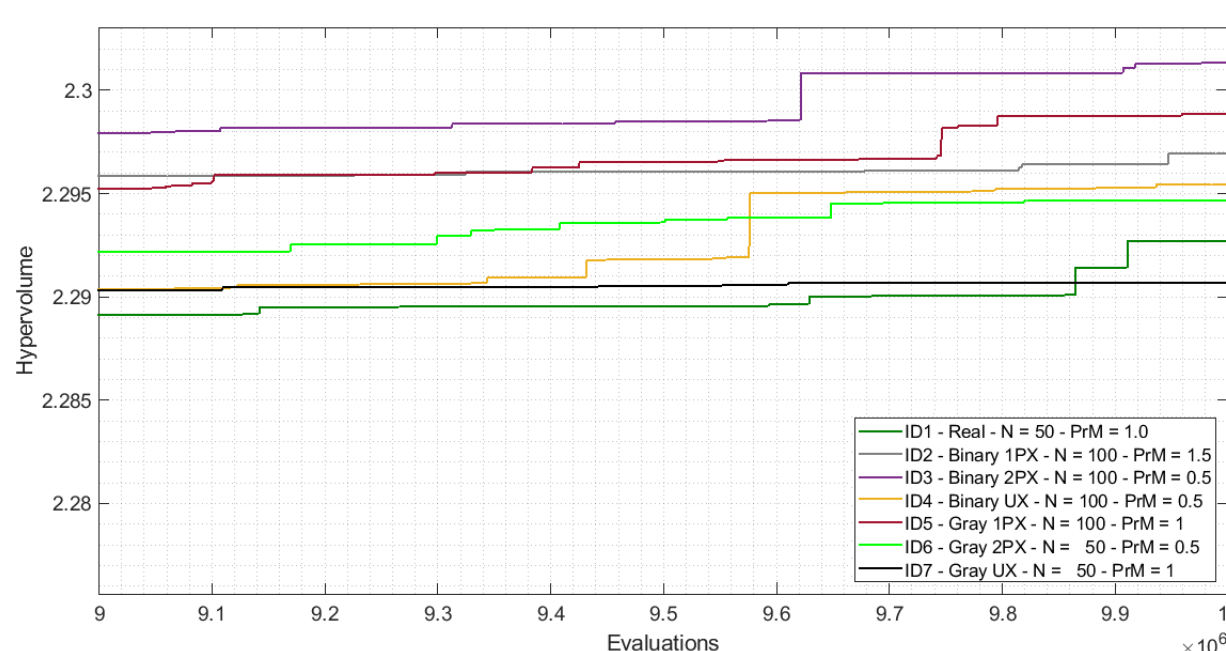
Figure 2. Hypervolume Average vs. evaluations (encoding